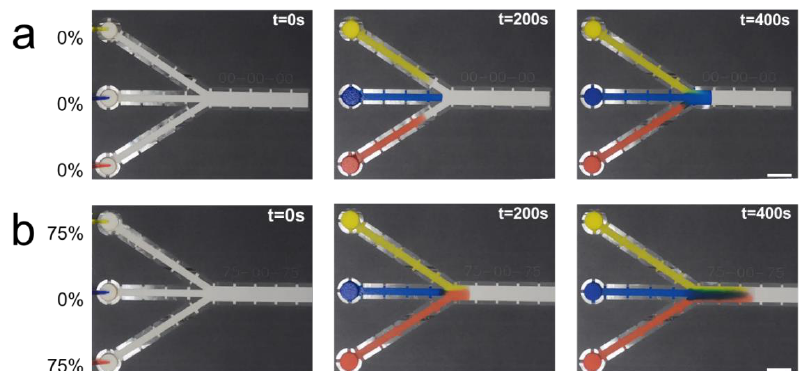
Figure 6. Time-lapse of the single-sided etched three-channel demonstration device. ( a ) All channels are unetched (0-0-0 device). The middle channel arrives at the intersection first, followed by the top and bottom channel that arrive nearly simultaneously. ( b ) The outer channels are etched at 75% and the middle channel is unetched (75-0-75 device). The outer channels arrive at the intersection simultaneously, while the middle channel takes longer. Scale bars are 10 mm.